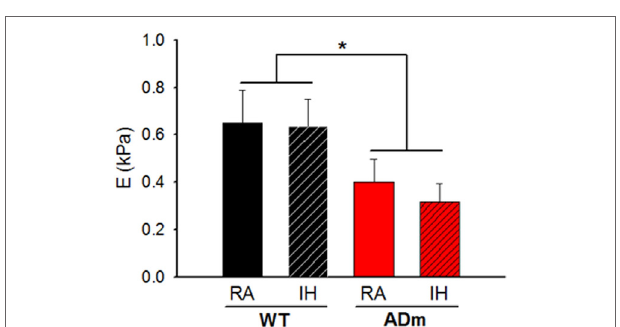
FigUre 3 | Stiffness of the cortex. The Young’s modulus ( E ) is a direct measurement of local tissue stiffness showing that cortical tissue was softer in ADm mice than in WT mice. E values from the four experimental groups, WT mice subjected to RA (black bar) and IH (dashed black bar) and ADm mice subjected to RA (red bar) and IH (dashed red bar). Cortical tissue stiffness was significantly lower in ADm mice vs. WT littermate controls (DF = 1, F = 6.198, p = 0.017). Two-way ANOVA, * p < 0.05. Data are presented as mean ± SE. WT, wild type; RA, room air; IH, intermittent hypoxia; ADm, Alzheimer’s disease transgenic mouse.